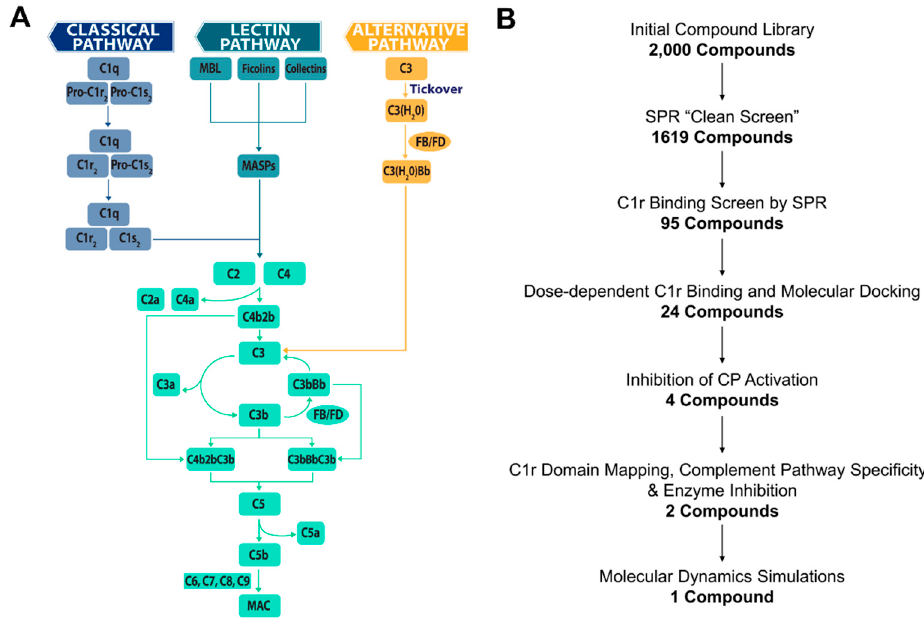
Figure 1. ( A ) Complement is activated by three canonical pathways known as the classical pathway (CP), lectin pathway (LP), or alternative pathway (AP). Activation of the classical pathway is controlled by the C1 complex (i.e., C1qC1r 2 C1s 2 ). The pattern recognition protein C1q binds to target surfaces resulting in the autoactivation of the zymogen C1r proteases (shown here as ‘Pro-C1r’) into C1r enzymes, which then proteolytically cleave and activate C1s within the C1 complex. The lectin pathway is activated by lectin pathway-specific pattern recognition proteins in complex with mannan-binding associated serine proteases (MASPs), while the alternative pathway is constitutively activated at low levels by a spontaneous hydrolytic event known as tick-over. Both the classical and lectin pathways converge at the cleavage of C2 and C4 to generate the classical / lectin pathway C3 convertases, C4b2b. Alternative pathway activation results in the formation of C3 convertases in the form of C3bBb. C3 convertases cleave the central molecule of the cascade, C3, into C3a and C3b, resulting in an amplification loop that produces increasing quantities of surface bound C3b. At high surface concentrations of C3b, C3 convertases bind an additional C3b molecule, resulting in a switch of substrate specificity to C5. Cleavage of C5 by these C5 convertases (i.e., C4b2bC3b and C3bBbC3b) results in the release of the anaphylatoxin C5a and the formation of the pore-like lytic structure called the membrane attack complex (i.e., C5b–C9). ( B ) Fragment-based drug discovery schematic.